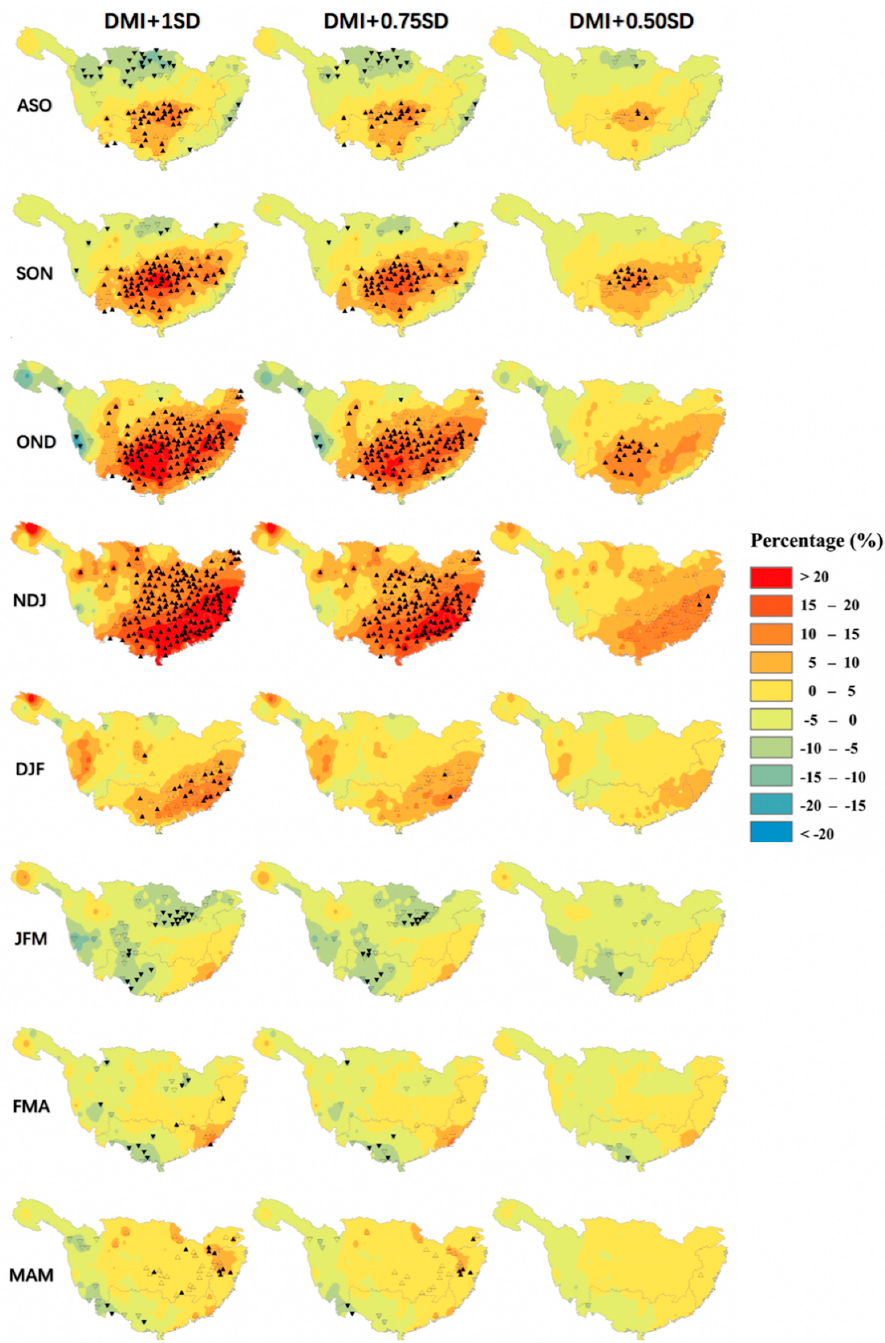
Figure 3. Intentionally biased bootstrapping simulations of three-month moving average precipitation from August–September–October (ASO) to March–April–May (MAM) over southern China with di ff erent thresholds (dipole mode index (DMI) + 1 standard deviation (SD), DMI + 0.75 SD, and DMI + 0.5 SD): Here, DMI + 1 SD represents the case in which the DMI is intentionally increased by a + 1-SD departure from the long-term average (1961–2017) to assess the impact of Indian Ocean Dipole (IOD) events on seasonal total precipitation. In each figure, percentage changes in seasonal precipitation are shown in red (blue) for increases (decreases). The weather stations showing statistically significant increases and decreases are indicated with regular and inverted triangles, respectively. In addition, the results of applying 90% and 95% confidence levels are marked by unfilled and filled symbols, respectively. For definitions of abbreviations, refer to Section